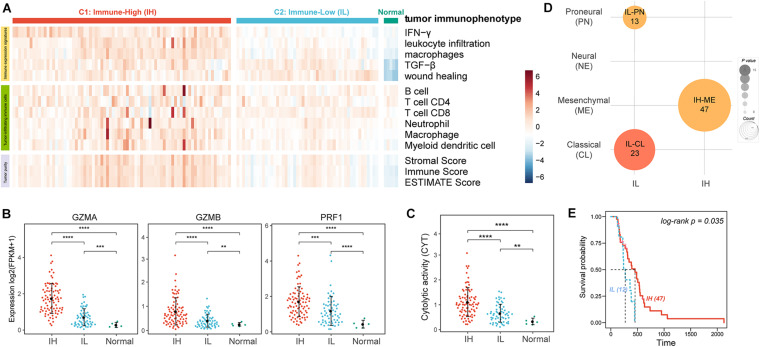
The tumor immune microenvironment of GBM. (A) Heatmaps showing the ssGSEA of immune expression signatures (first five lines), the levels of tumor-infiltrating immune cells (sixth to twelfth lines), and tumor purity (last three lines) in GBM patients. (B) The expression levels of effectors of immunity log2(FPKM+1). (C) The CYT of GBM patients. (D) Enrichment analysis of GBM subtypes and GBM immunophenotypes. (E) The KM survival curve showing the impact of immune subtypes on the survival of ME GBM patients. **P < 0.01, ***P < 0.001, ****P < 0.0001.